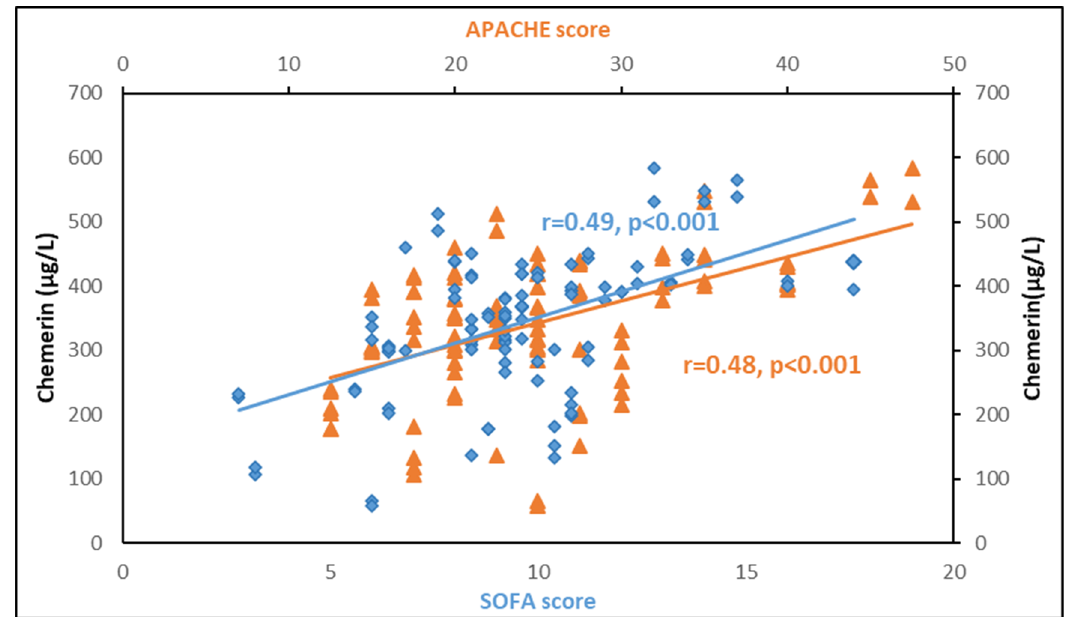
Figure 7. Circulating chemerin is significantly associated with APACHE II and SOFA scores at sepsis onset in 102 critically ill septic patients. onset in 102 critically ill septic